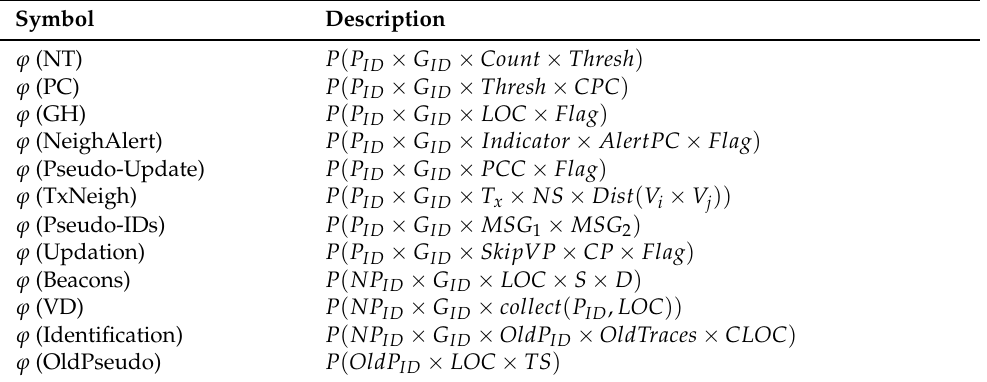
Table 5. Places used in HLPN for attacker scenario in DGVP